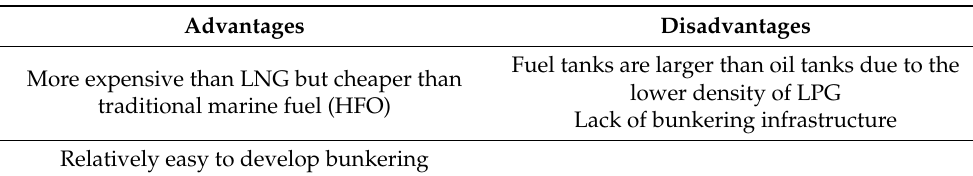
Table 3. An overview of the advantages and disadvantages of LPG as an alternative fuel for the shipping sector [48,65,71].